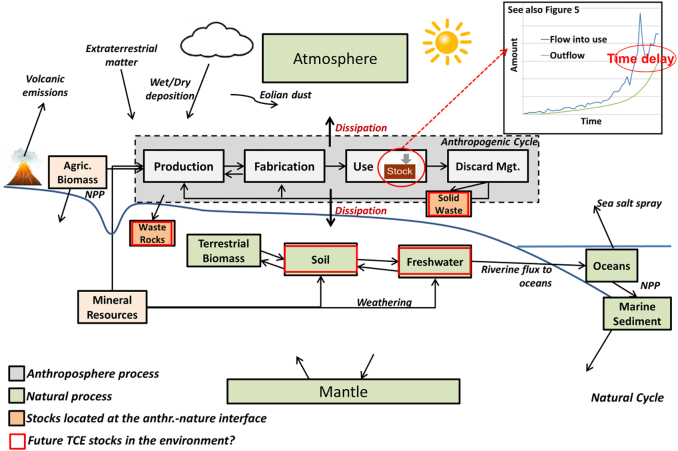
Schematic illustration of the anthropogenic cycle of an element located within the larger natural cycle (inspired by (Rauch and Pacyna, 2009, White and Hemond, 2012)). NPP: Net primary productivity.